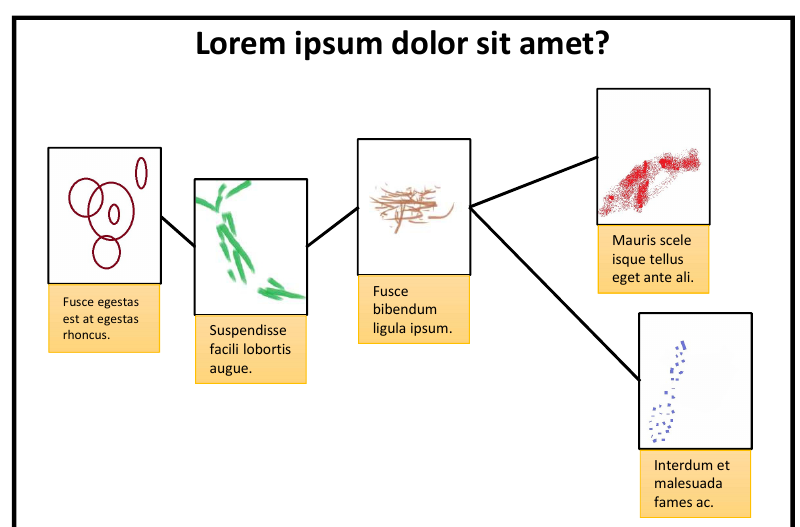
Figure 6: An illustration of the graph-node structured narrative of HTVAP. It consists of a set of ordered and annotated snapshots of visualization states. This fictional example uses lorem ipsum instead of real